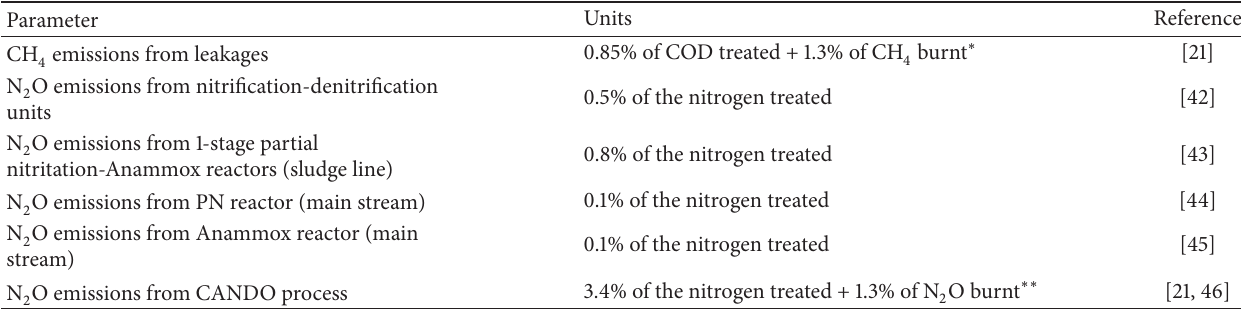
Table 2: Values assigned to the parameters used to estimate GHG emissions for the case